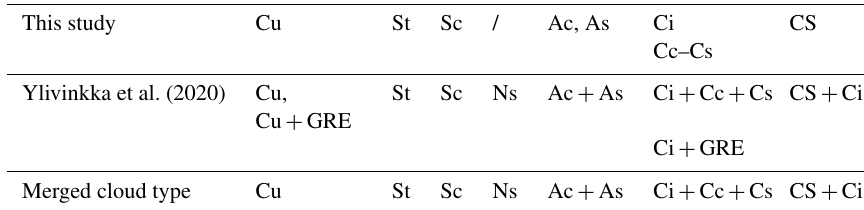
Table B3. Cloud class homogenization adopted for comparison purposes (merged cloud type) between the present study’s cloud classification and the one reported in Ylivinkka et al. (2020).